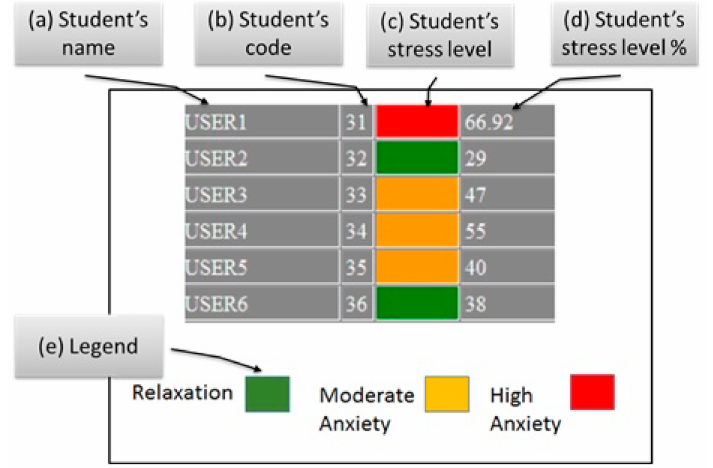
Figure 4. Instructor monitoring